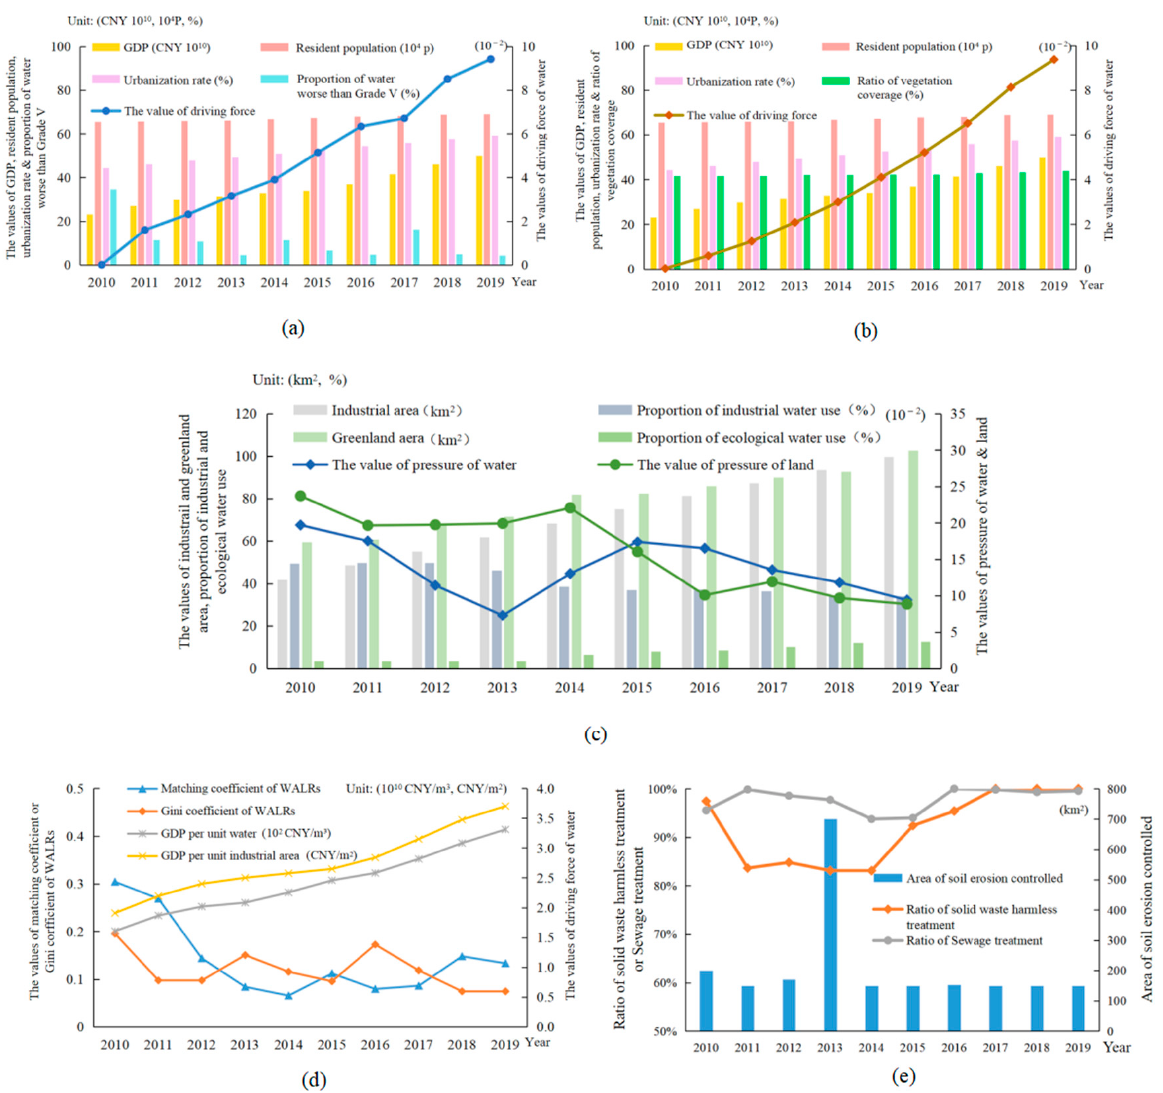
Figure 9. Part of the indexes with remarkable changes from 2010 to 2019: ( a , b ) main driving force indexes of water and land respectively, ( c ) trends of two representative resources utilization states, ( d ) trends of the matching degree and GDP per unit resources, and ( e ) measures taken to avoid degradation by humans.